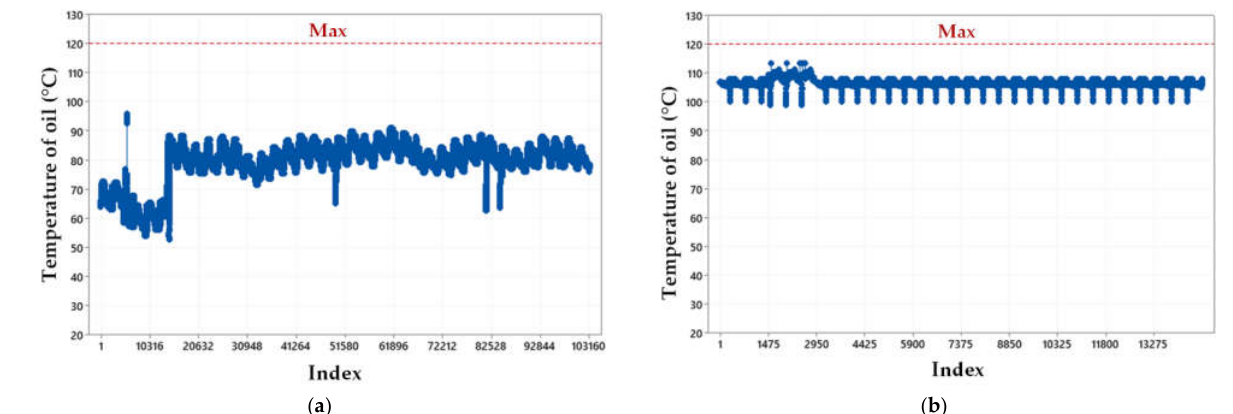
Figure 11. Oil temperature monitoring for ( a ) low condition (500 rpm camshaft), and ( b ) high condition (2500 rpm camshaft).